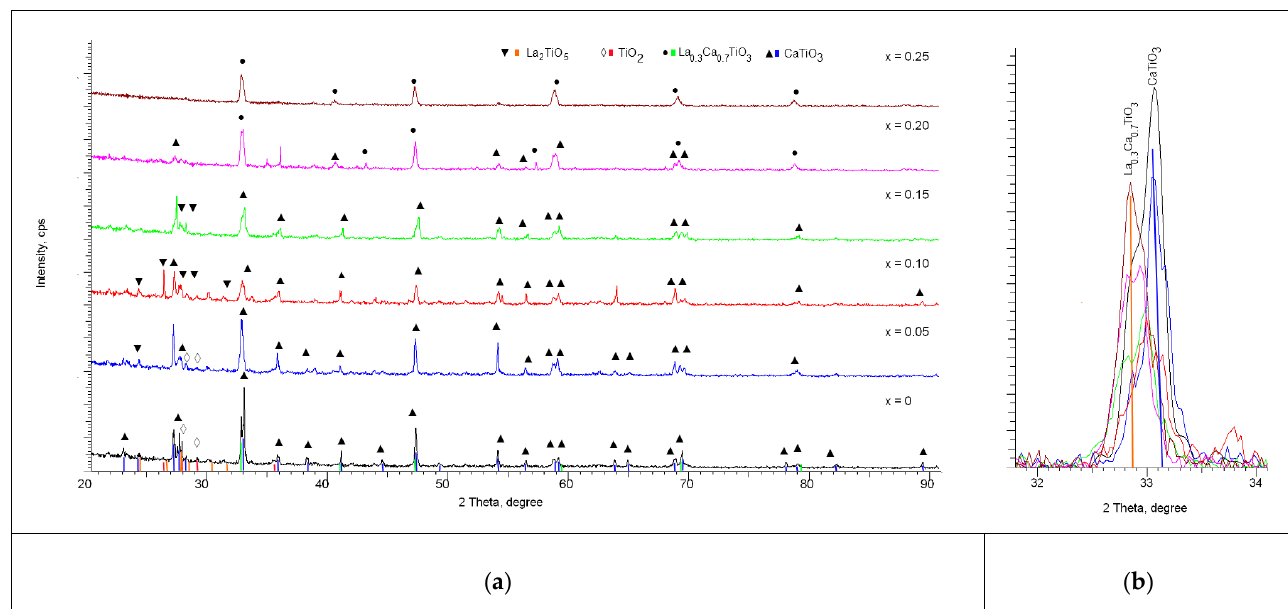
Figure 1. ( a ) X-ray diffractograms of synthesized samples of CaTiO 3 perovskite-like ceramics doped with lanthanum (La); ( b ) Detailed change of the main reflex.